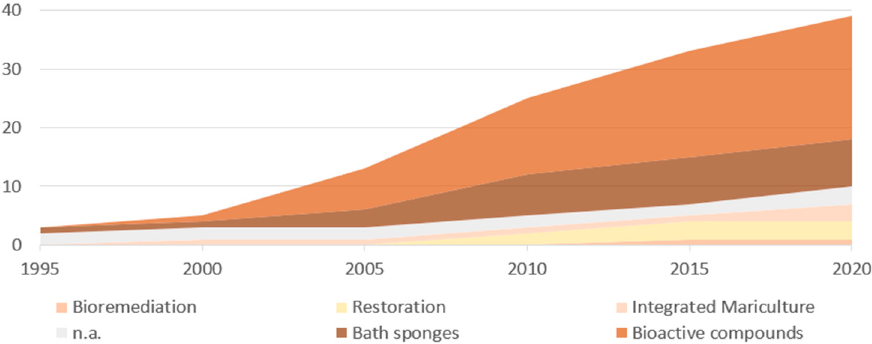
Figure 2. The number of publications on sponge in situ cultivation (included in this review) that were related to different selected commercial interests over time. Table 2. Description of categorized transplantation techniques. Technique